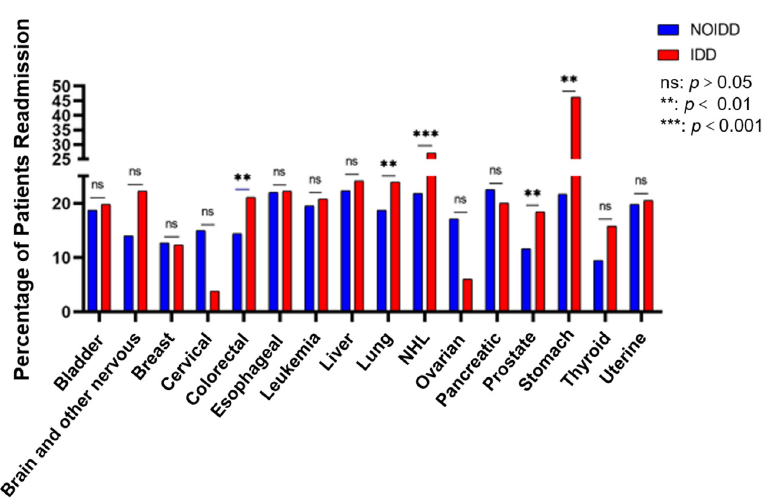
Figure 3. Malignancy patients with IDDs compared with those with NOIDDs of the 30-day unplanned readmission group.